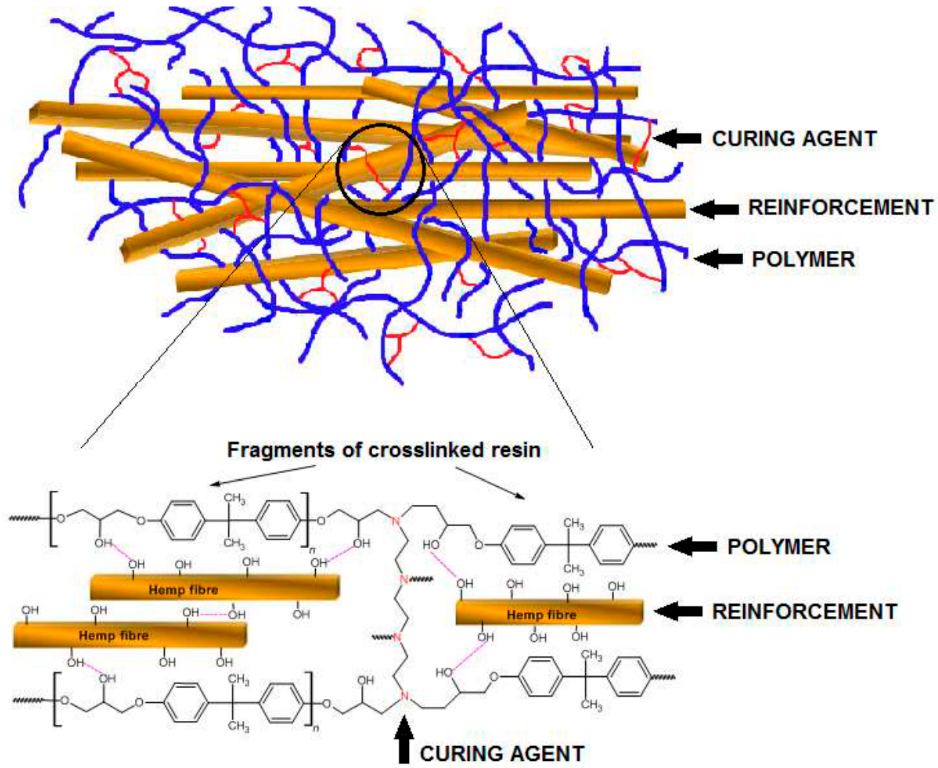
Figure 8. The schematic representation of intermolecular interaction between the hemp fiber, epoxy resin, and the curing agent (triethylenetetramine) [58]. (Open access).